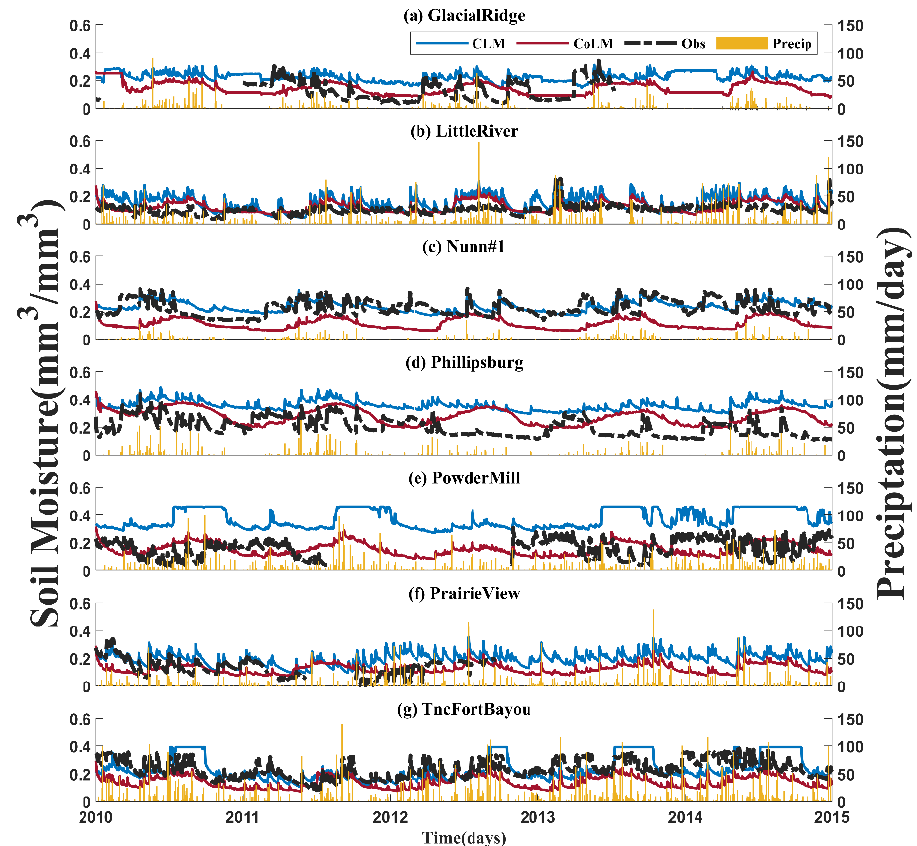
Figure 3. Simulated and observed temporal soil moisture variations at the SCAN sites for 2010 – 2014 at a soil depth of 0.1016 m. The blue line is the CLM5 simulation, the red line is the CoLM2014 simulation, the dashed line is the observations, and the yellow bars are the daily cumulative precip- itation. ( a – g ) Glacial Ridge, Little River, Nunn#1, Phillipsburg, Powder Mill, Prairie View, and Tnc Fort Bayou, respectively.